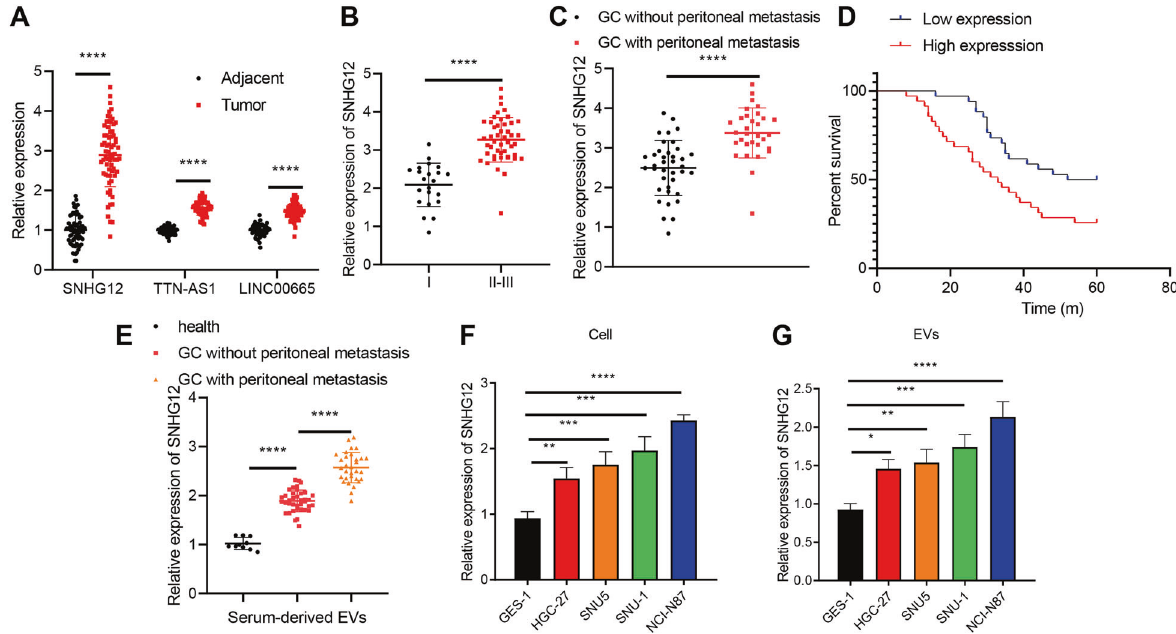
Fig. 2 The expression pattern of SNHG12 in GC tissues and cells and its relationship with peritoneal metastasis and prognosis in patients with GC. A The expression of SNHG12, LINC00665, and TTN-AS1 in GC and adjacent normal tissues examined using RT-qPCR ( n = 69). B The relative level of SNHG12 in GC tissues from patients with GC of different clinical stages (I ( n = 22); II and III ( n = 47)) determined using RT-qPCR. C SNHG12 expression pattern in GC tissues with peritoneal metastasis ( n = 31) and GC tissues without peritoneal metastasis ( n = 38) from patients with GC detected by RT-qPCR. D The correlation between SNHG12 expression pattern and the overall survival of patients with GC analyzed by Kaplan – Meier survival curve. E The expression pattern of SNHG12 in serum-derived EVs in 10 healthy volunteers, 38 patients with non-metastatic GC, and 31 patients with metastatic GC determined by RT-qPCR. F SNHG12 expression pattern in normal human gastric mucosal cells GES-1 and GC cell lines HGC-27, NCI-N87, SNU-1, and SNU5 measured using RT-qPCR. G SNHG12 expression pattern in EVs isolated from each group of GC cells evaluated by RT-qPCR. * p < 0.05, ** p < 0.01, *** p < 0.001, **** p < 0.0001. The experiment was conducted three times